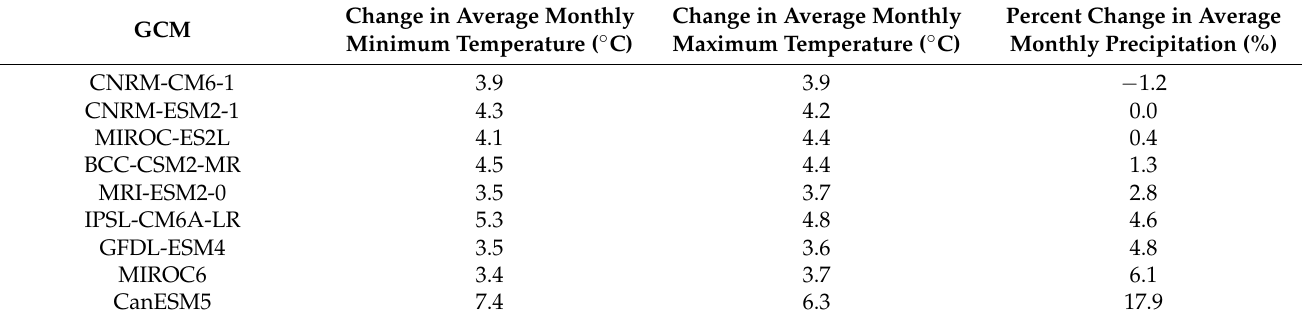
Table A2. Change in average monthly temperature and precipitation in Mongolia across all months of the year, relative to current average conditions, according to nine global climate models (GCMs). These refer to future predictions under the SSP3-7.0 scenario and for the time period